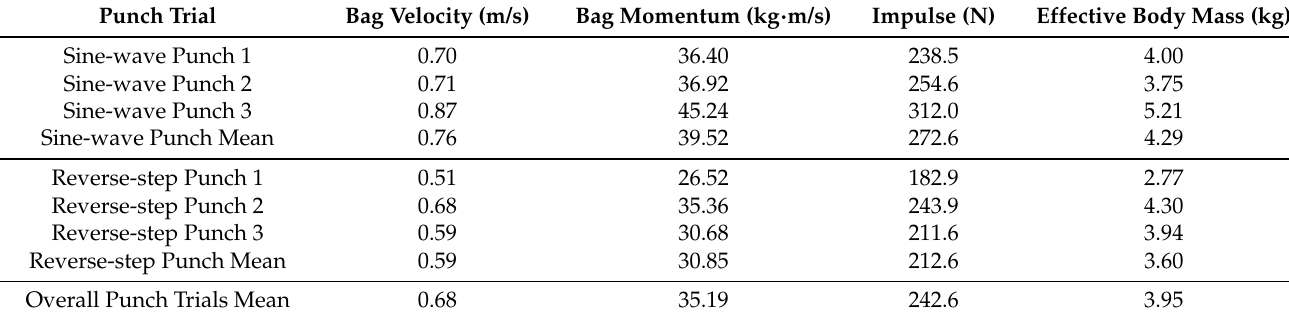
Table 3. Momentum and impulse results for Sine-wave punch and Reverse-step Punch Trials.